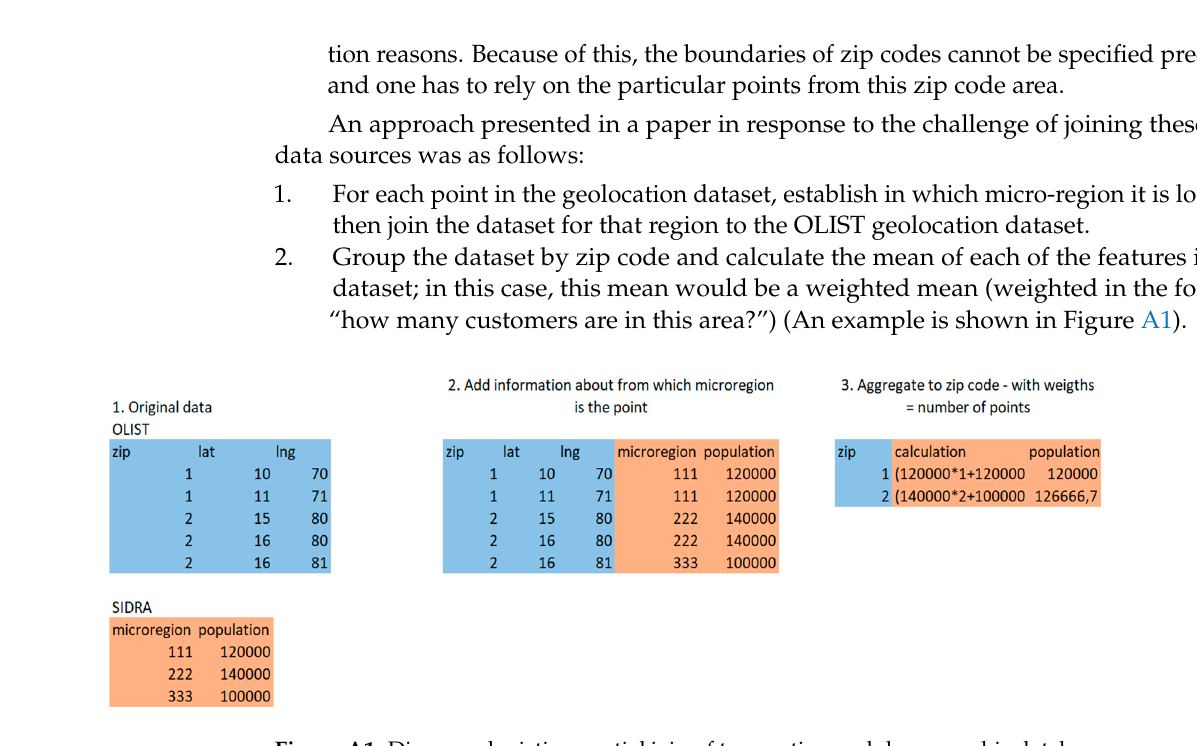
Figure A1. Diagram depicting spatial join of transaction and demographic databases.